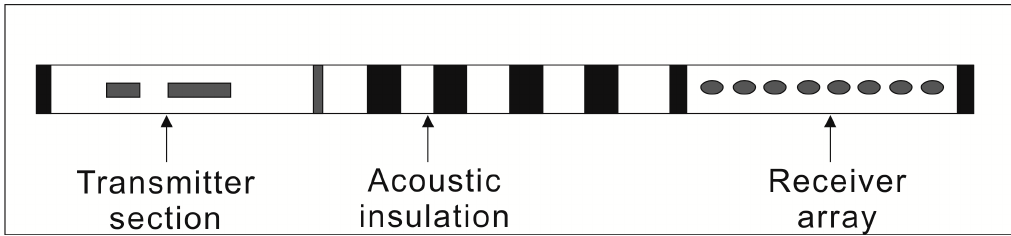
Figure 1. Structural schematic for the acoustic system of the dipole array acoustic logging tool.